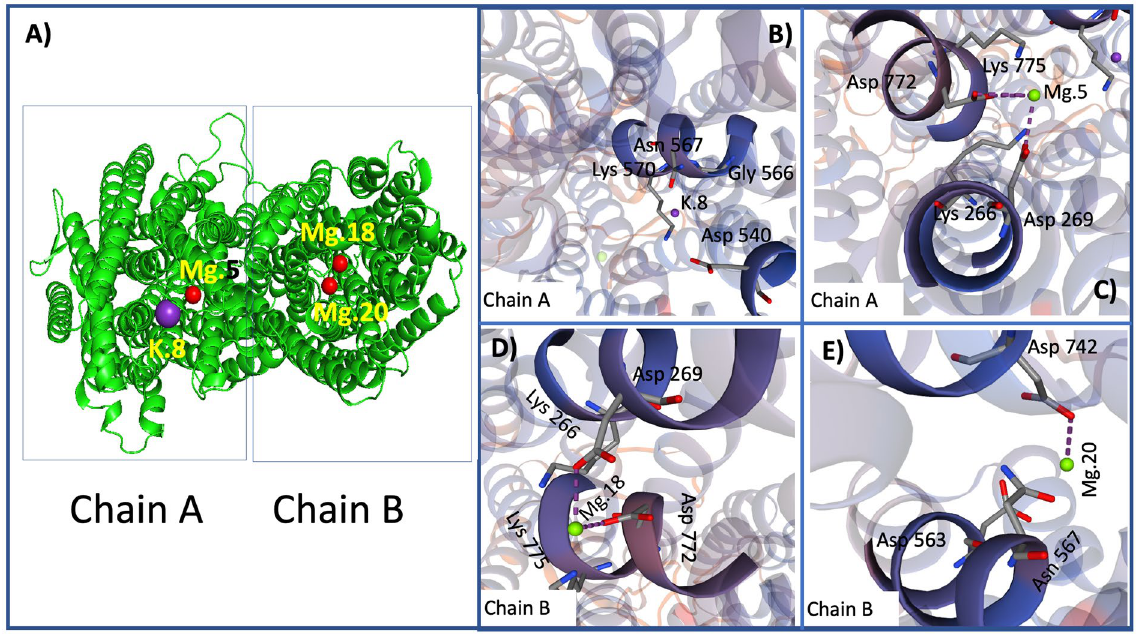
Figure 3. ( A ) Modelling of the three-dimensional structure corresponding to the protein sequence of the isoenzyme PdVP2 of the H + -PPase of P. dicentrarchi . The homodimeric type oligomeric modelling obtained from the quaternary structure is included, indicating the existence of two monomeric chains A and B (circles). The model predicts one ligand for K + and three ligands for Mg +2 ( B – E ). K.8 has four coordination residues, and no protein–ligand interactions (PLIPs) were detected ( B ). Mg. 5 presents four coordination residues and three PLIPs in the A chain forming metal complexes ( C ). Mg.18 has four coordination residues and two PLIPs in the B chain protein forming metal complexes ( D ). Mg. 20 has three coordination residues and one PLIP in the B chain forming metal complexes ( E ). Templates were obtained by an automated comparative protein modelling server of the Swiss Model (URL: https:// swiss model. expasy.